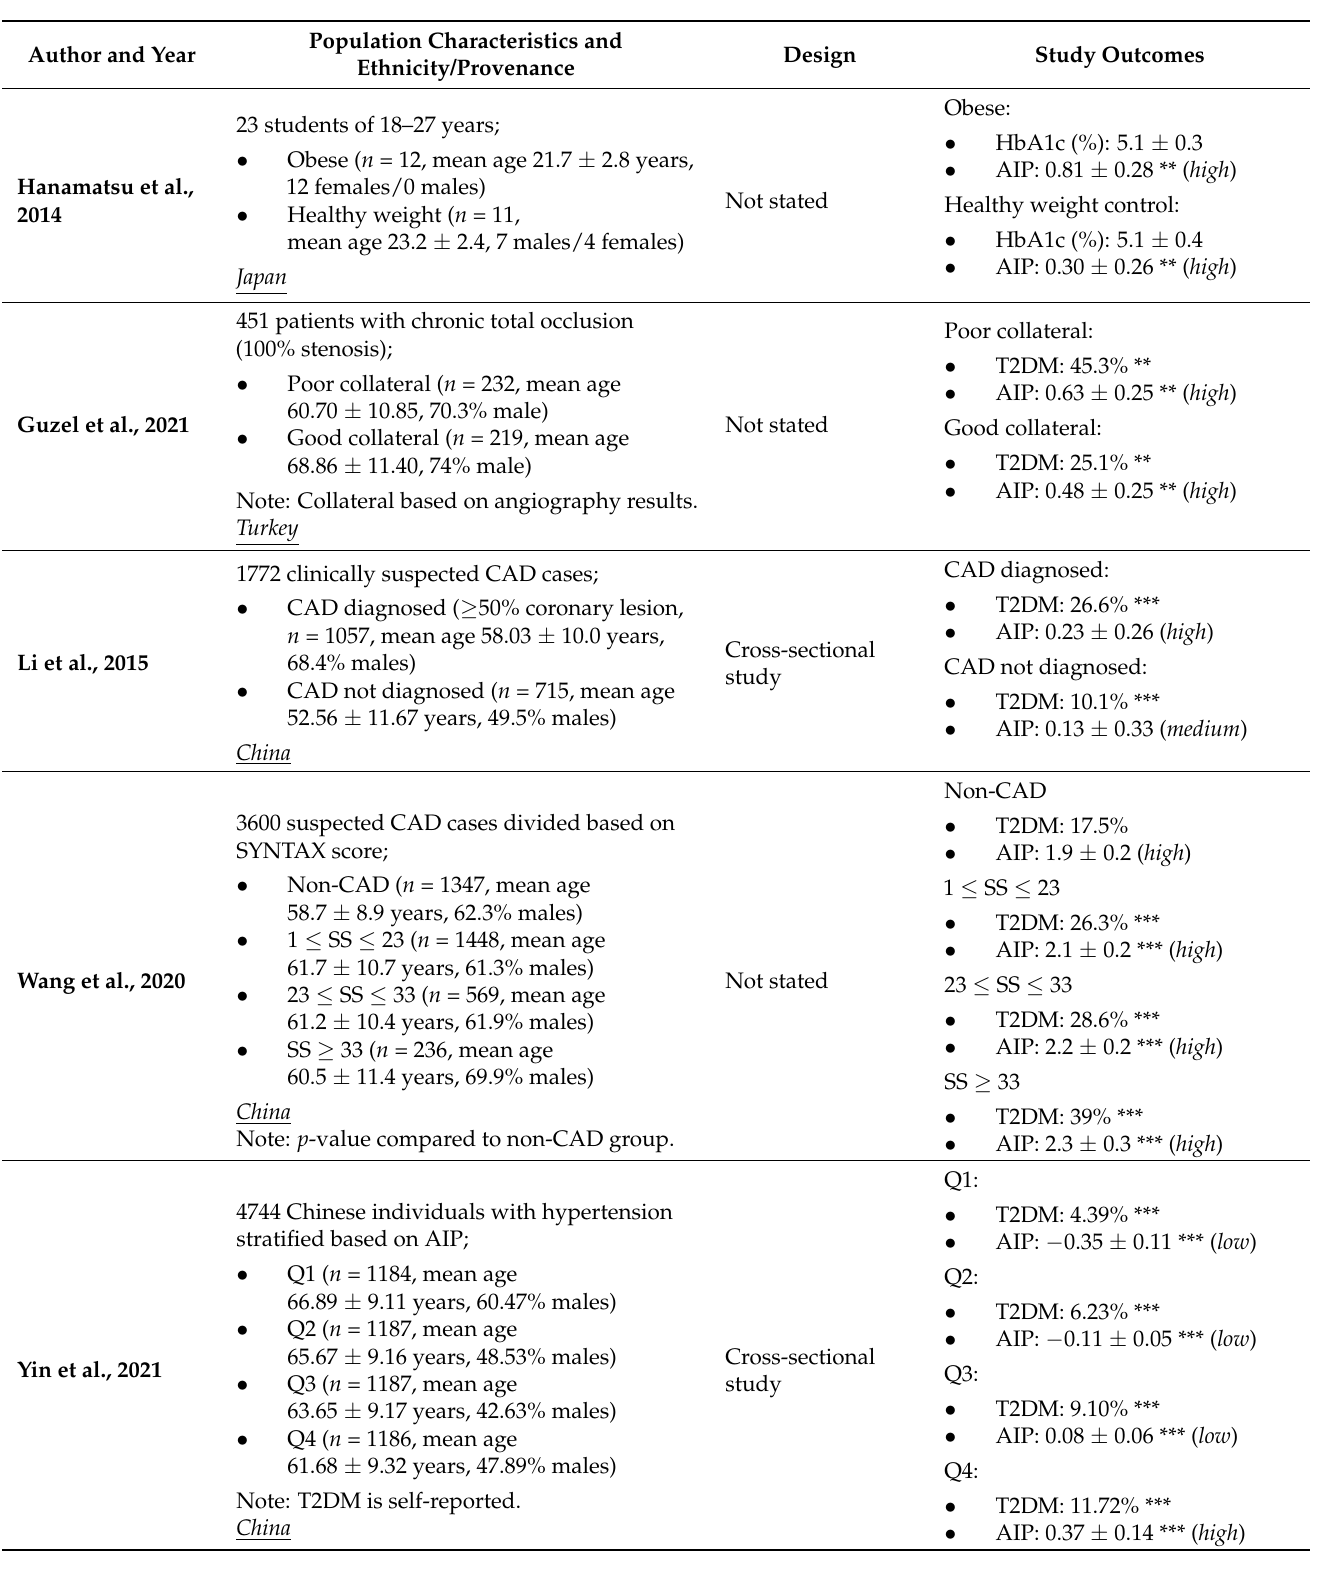
Table 5. Outline of the studies interlinking blood glucose data and AIP. Author, year, subject characteristics, study design, primary outcomes, and other study outcomes of interest (HbA1c, T2DM, blood glucose, insulin) are presented for each study where available